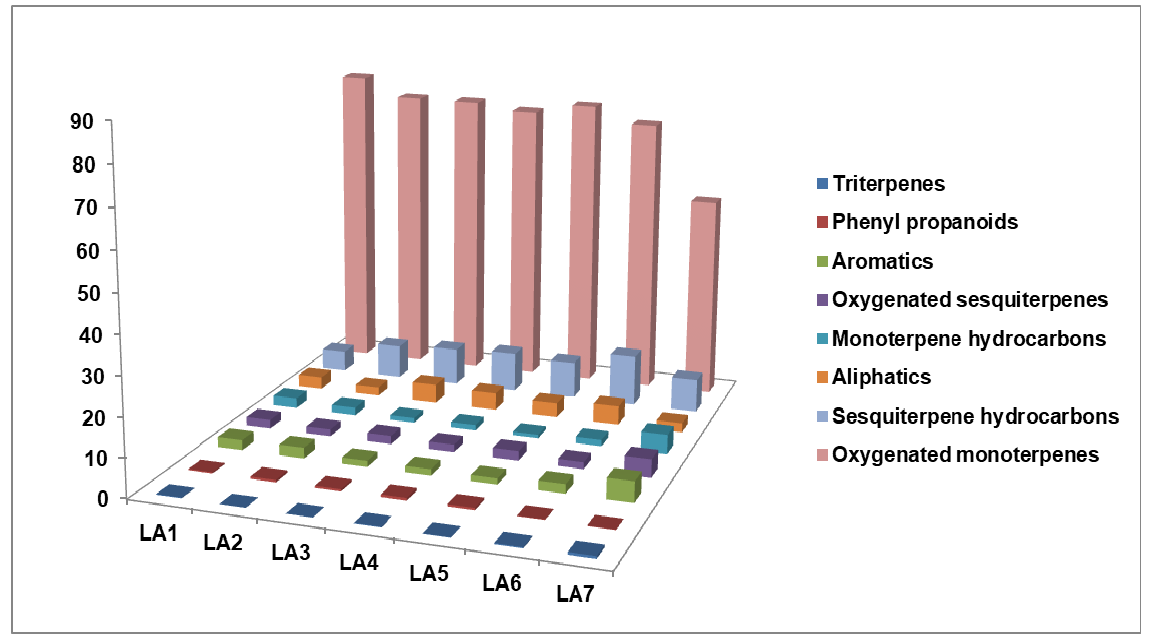
Figure 2. Main chemical class distribution in the studied LA